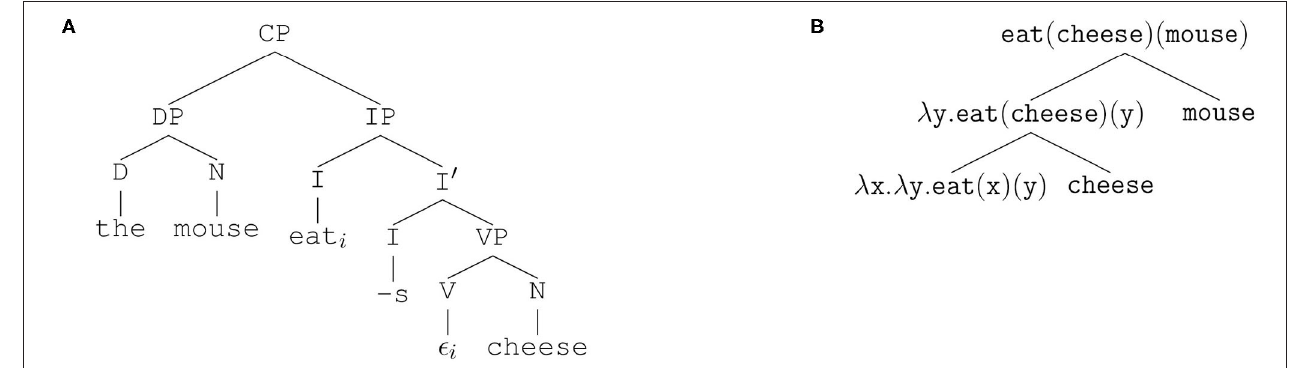
FIGURE 2 | Generative grammar analysis of example UMP (Equation 2). (A) Syntactic phrase structure tree. (B) Semantic tree from lambda